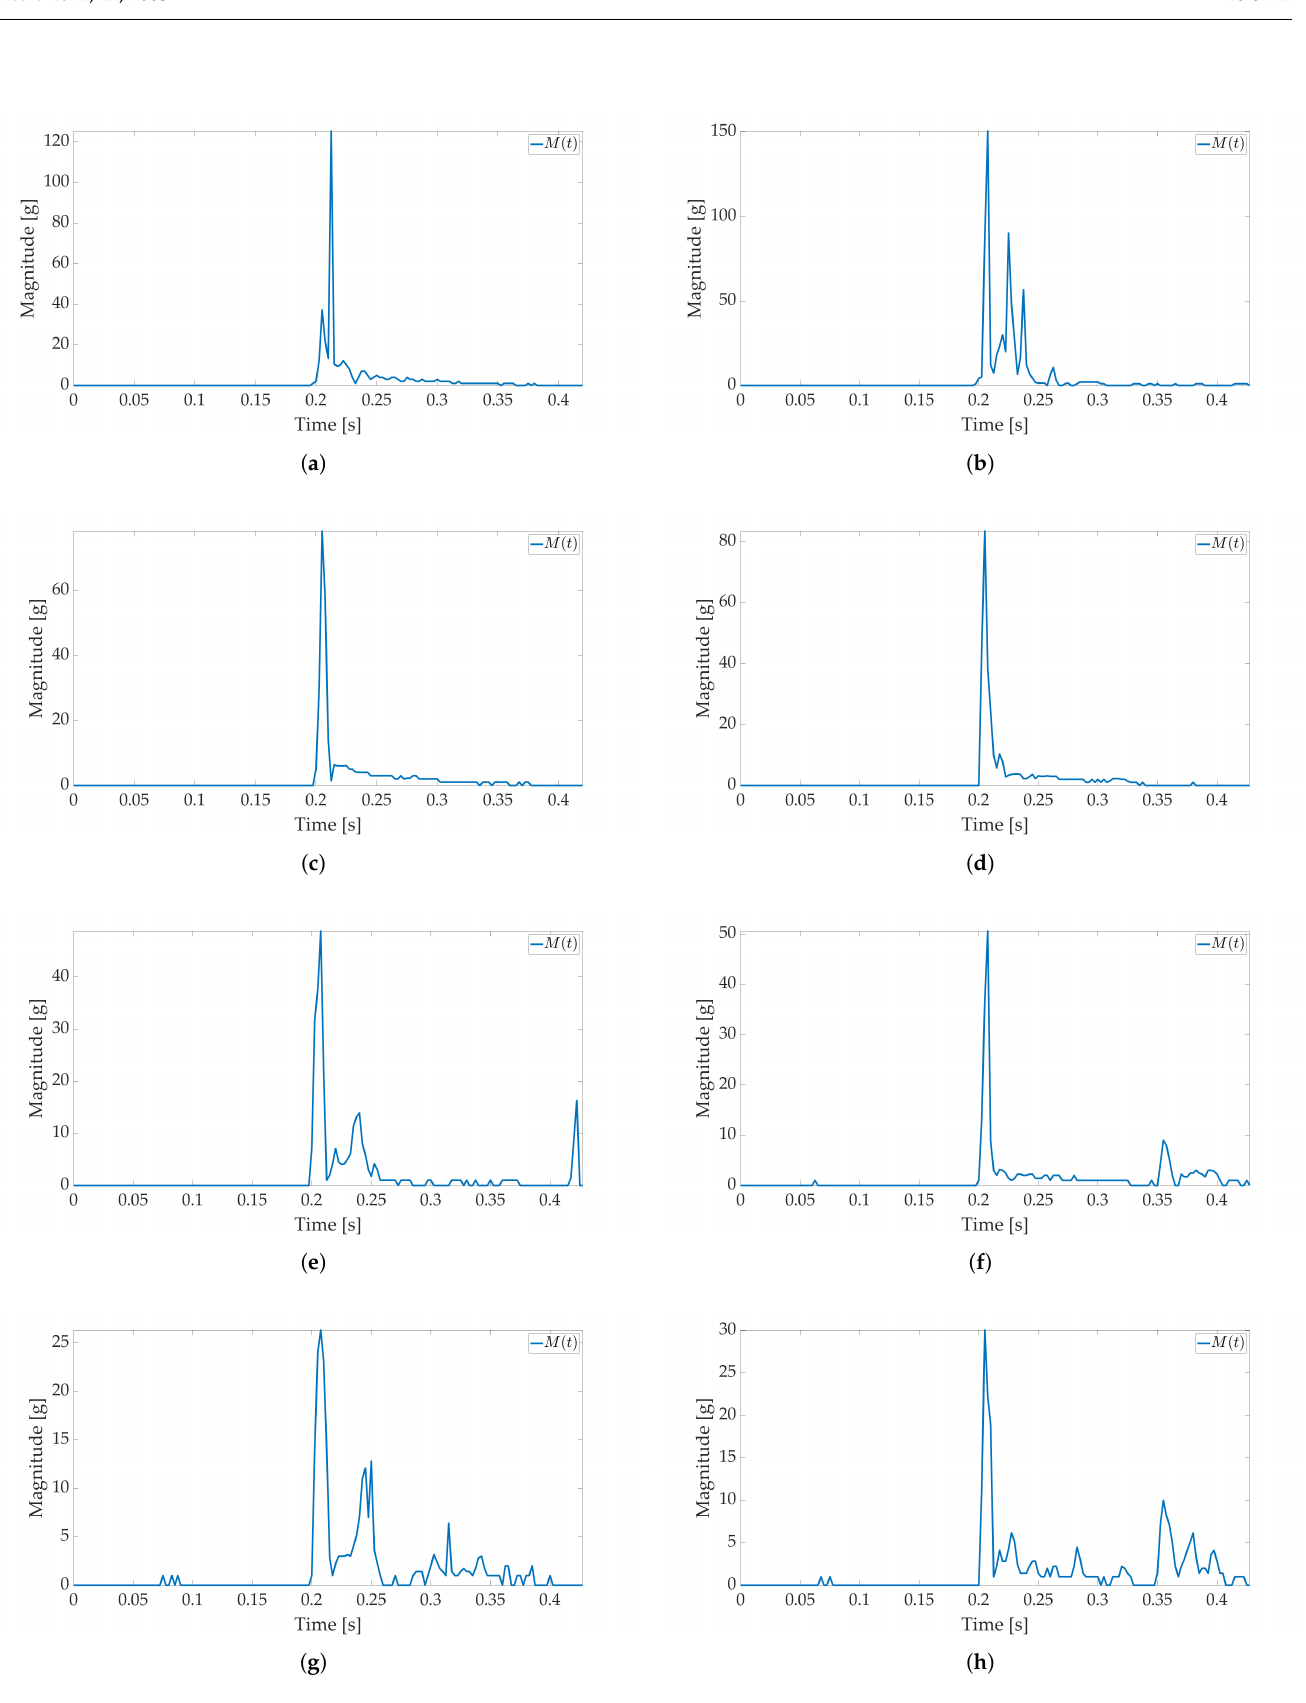
Figure 13. Shock detection values for package falling vertically from various heights (400 Hz with FIFO). Acceleration magnitude waveform: measured inside the package on figures ( a ) (100 cm), ( c ) (50 cm), ( e ) (20 cm), ( g ) (10 cm); measured on the package on figures ( b ) (100 cm), ( d ) (50 cm), ( f ) (20 cm), ( h ) (10